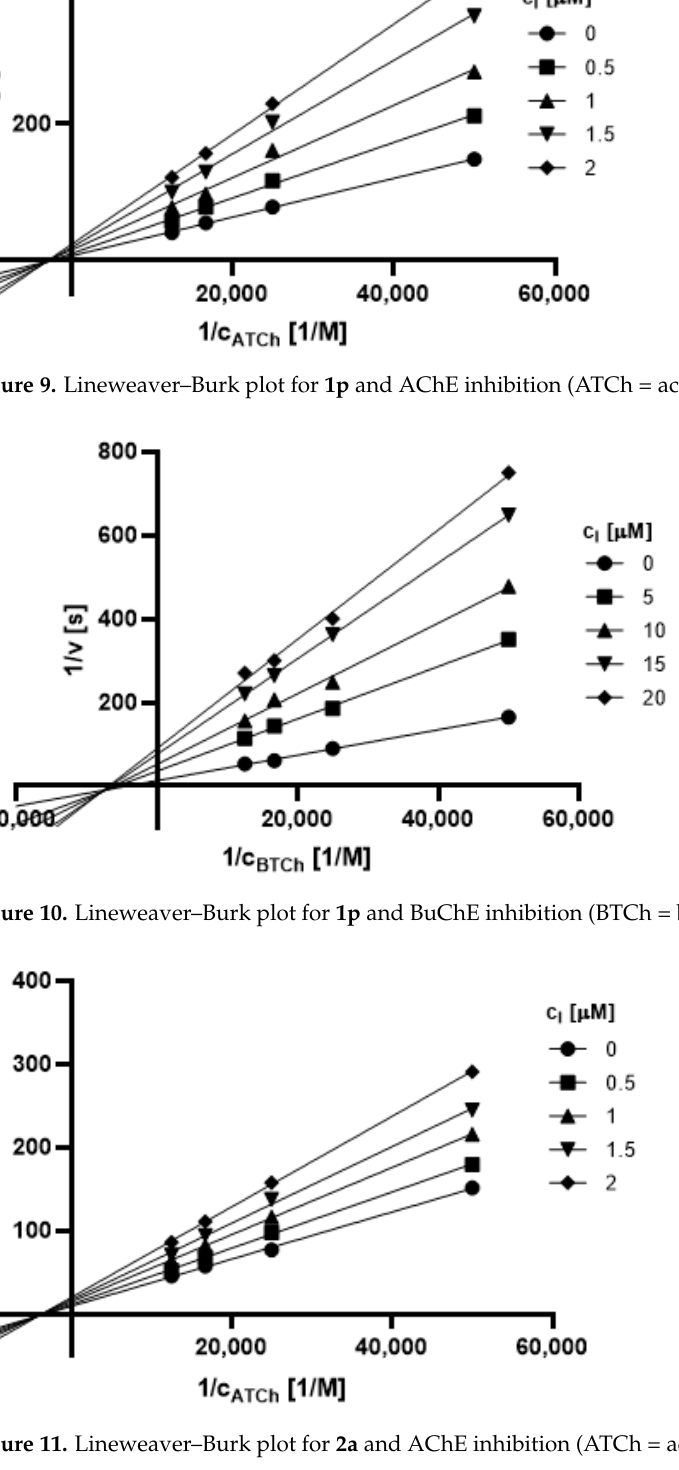
Figure 12. Lineweaver–Burk plot for 2a and BuChE inhibition (BTCh = butyrylthiocholine). Figure 13. Lineweaver–Burk plot for 2e and AChE inhibition (ATCh = acetylthiocholine).